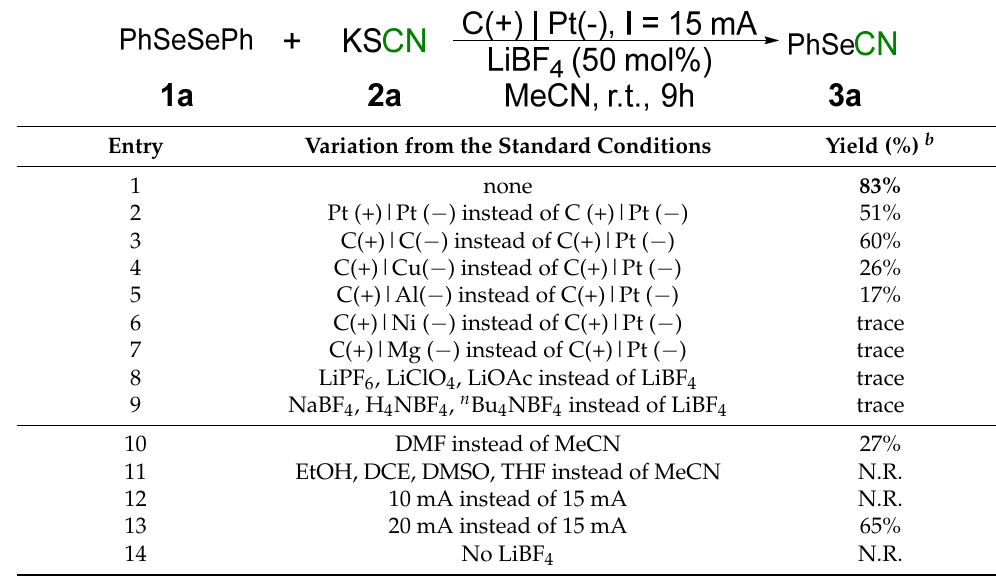
Table 1. Optimization of the reaction conditions a .